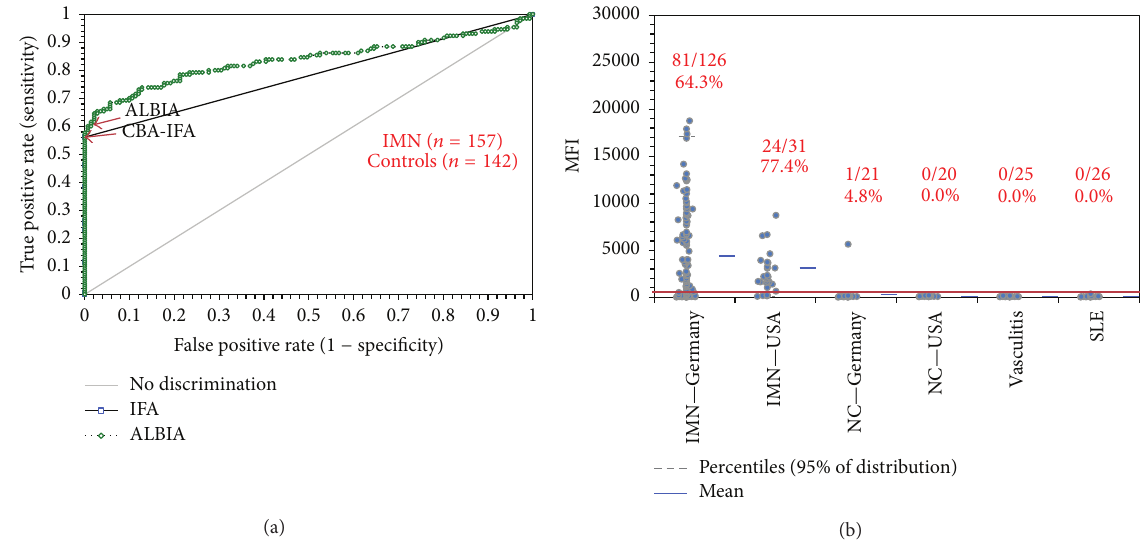
Figure 3: Comparative analysis (IMN versus controls). ALBIA and the CBA-IFA were compared to the diagnosis of the subjects tested. (a) With an area under the curve (AUC) of 0.78 (95% CI: 0.74–0.82) for CBA-IFA and of 0.84 (95% CI: 0.78–0.89) for ALBIA, both assays showed similar discrimination between IMN and controls. Cut-off values are indicated by the arrows. (b) Comparative descriptive analysis shows the prevalence of anti-PLA 2 R antibodies in different cohorts measured by